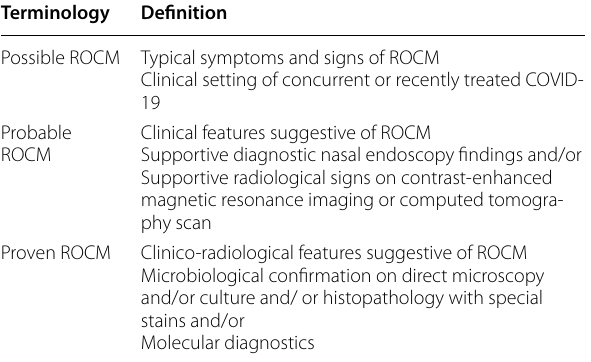
Table 3 Patient symptom distribution Symptoms